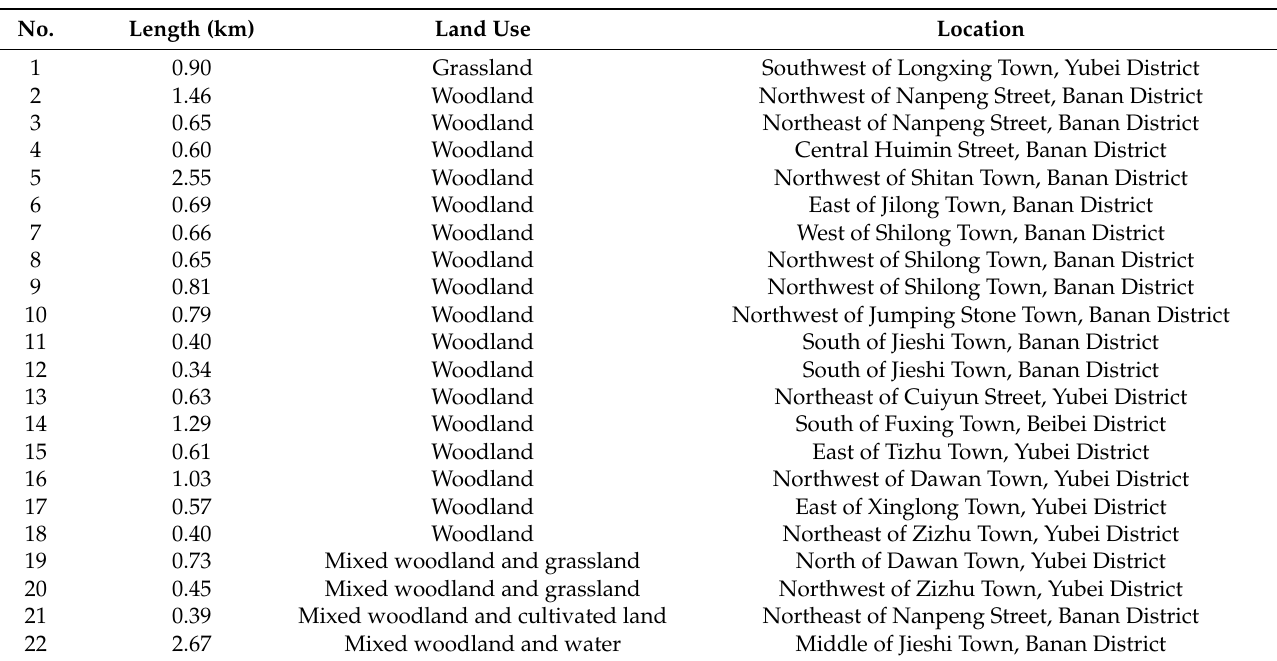
Table 12. The length and location of ecological “pinch